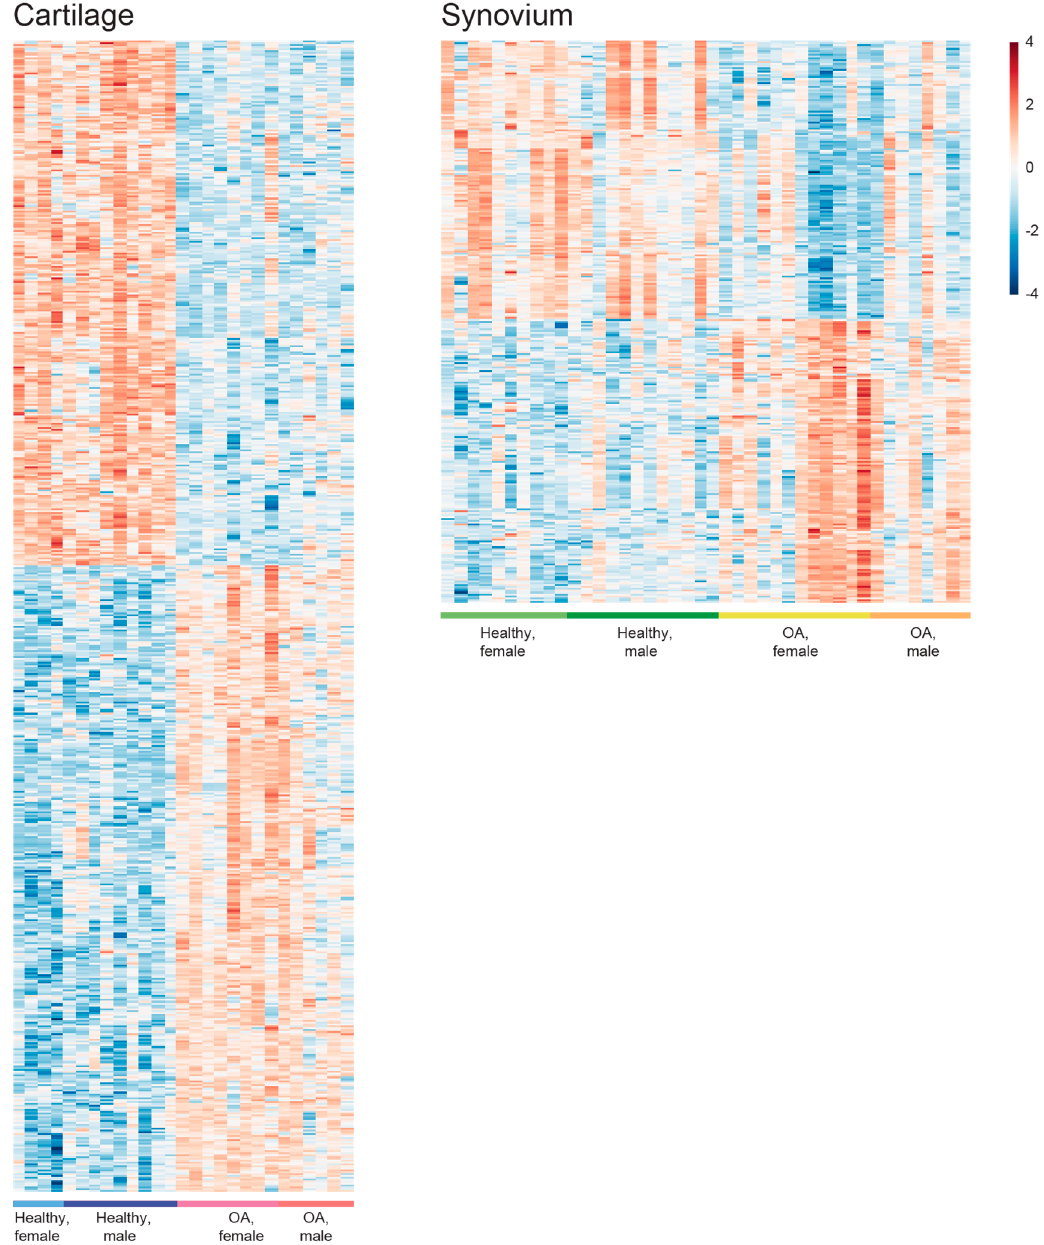
Figure 2. Heatmaps visualize the osteoarthritis (OA)-responsive differential expressed genes (DEGs) in cartilage and synovium, respectively.